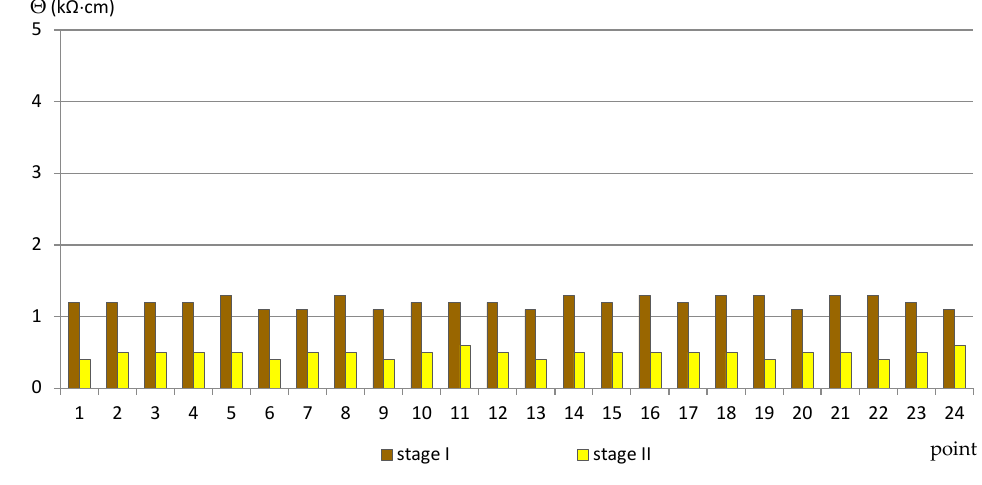
Concrete cover resistivity; Concrete specimens with CEM I and without an air-entraining agent